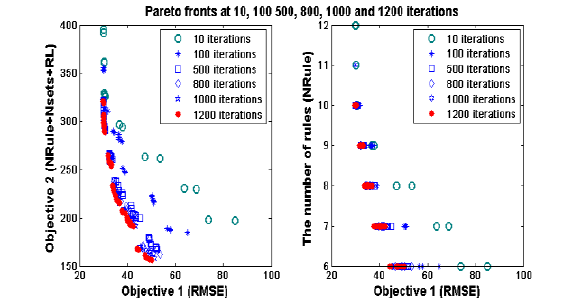
Fig. 18. The fuzzy sets of input 13 (hardening tempature), 5 (Si) and output (UTS) from the second (left) and the third modeling stage (right).